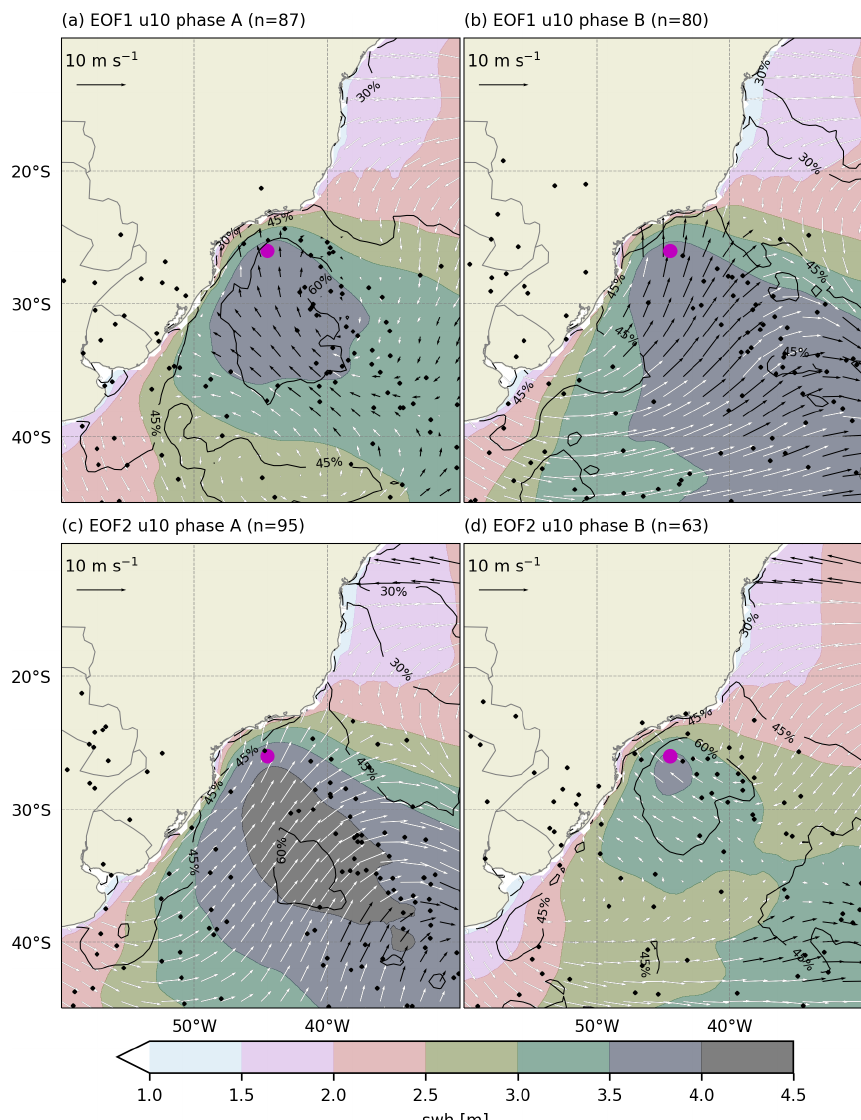
Figure 9. Composite of the total swh (shaded) for the high-wave occurrence in the SBB (purple dot; 30 ◦ S, 45 ◦ W) in the phases (a, c) A and (b, d) B for (a, b) EOF1 and (c, d) EOF2. The shws is shown as a percentage from the swh in contour lines, and the 10m wind is indicated by the vector fields. White vectors are areas where the differences of swh between phases of a given mode are within the 95% confidence